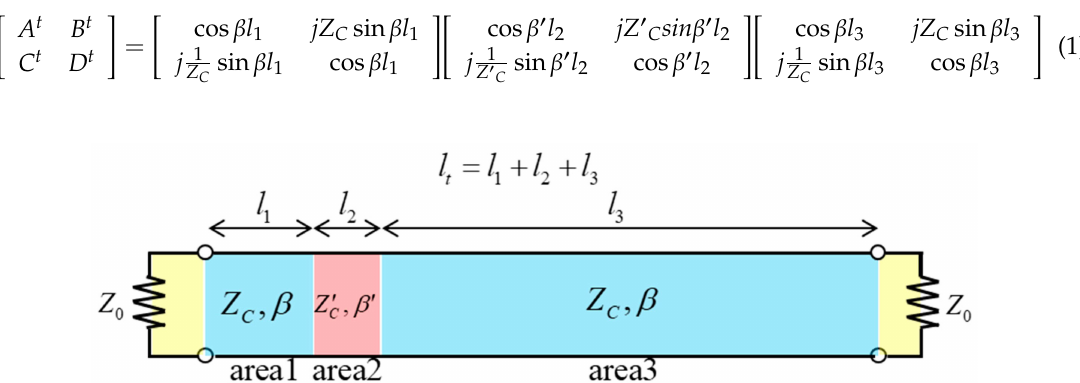
Figure 2. Discontinuous transmission line model. The pink part is introduced for the degraded insulator, and the two sky blue parts are in healthy